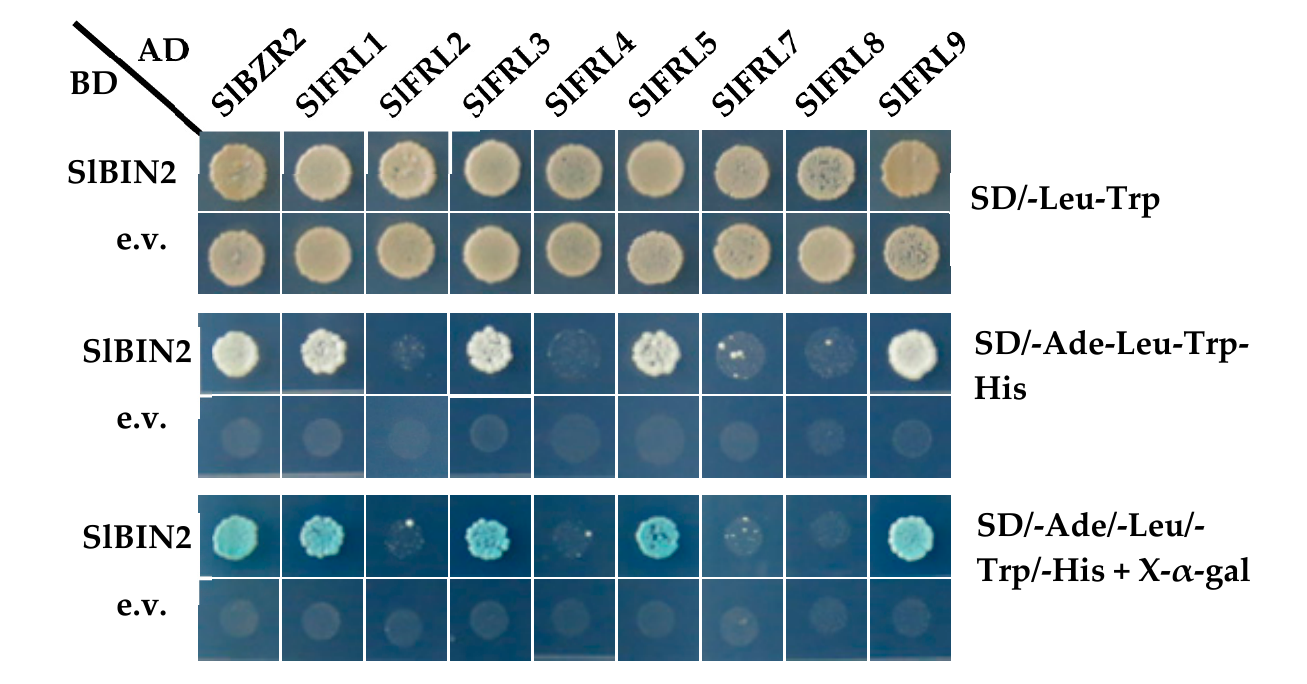
Figure 2. Four SlFRLs physically interact with SlBIN2 in yeast.